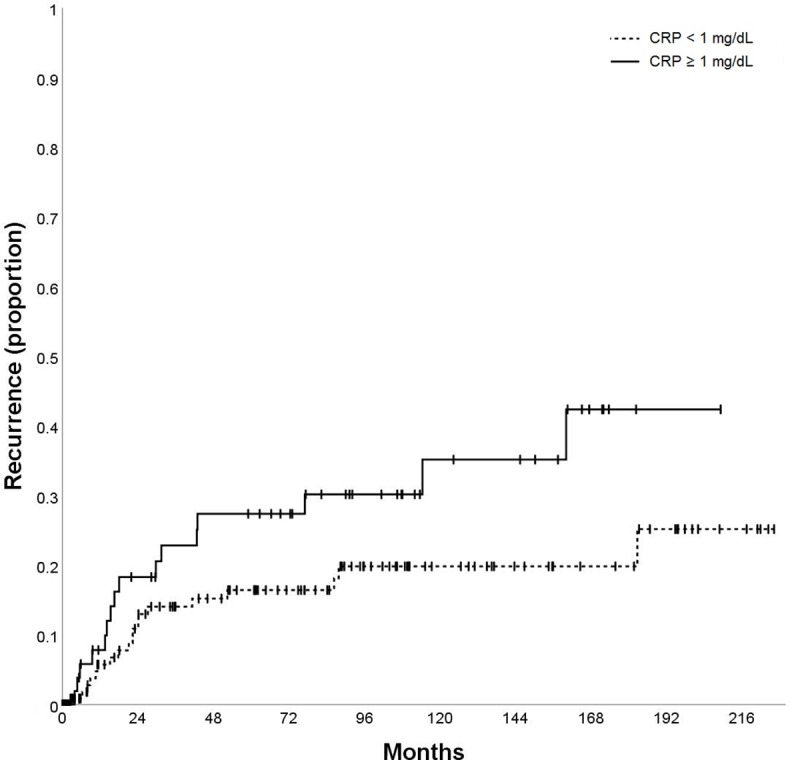
Kaplan-Meier curve according to serum C-reactive protein (CRP) level: Time to recurrence (TTR) according to CRP ≥ 1 mg/dL vs. CRP < 1 mg/dL.